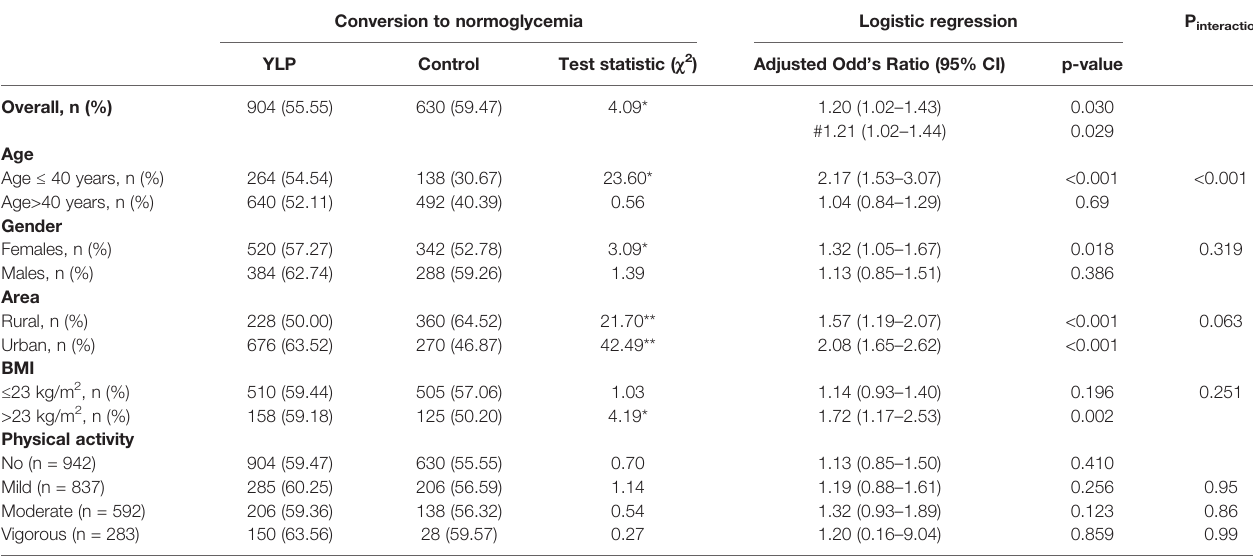
TABLE 3 | Generalized linear mixed model analyses for conversion from prediabetes to normoglycemia in the YLP and the control groups at 3 months of follow-up. Conversion to normoglycemia Logistic